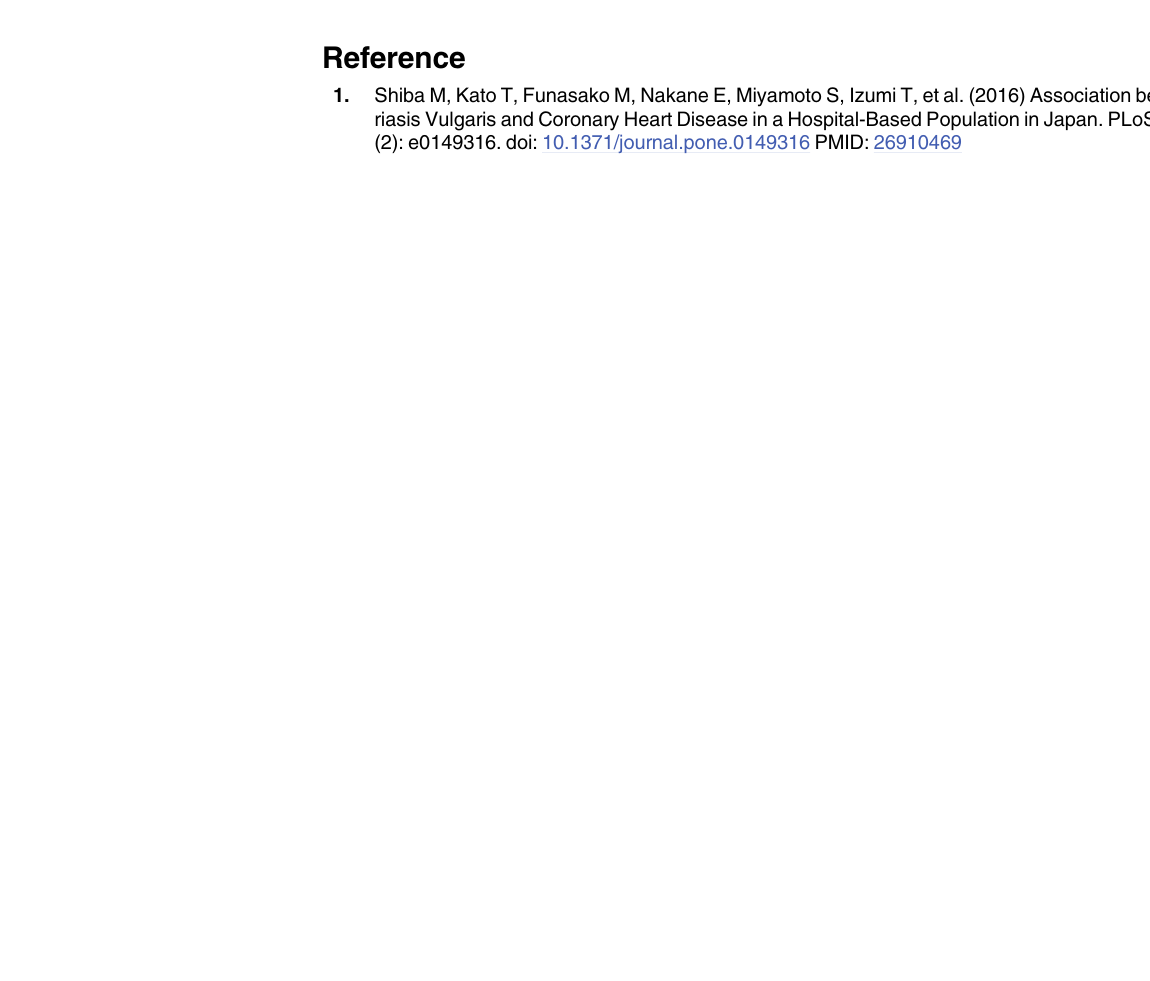
PLOS ONE | DOI:10.1371/journal.pone.0158699 June 29,